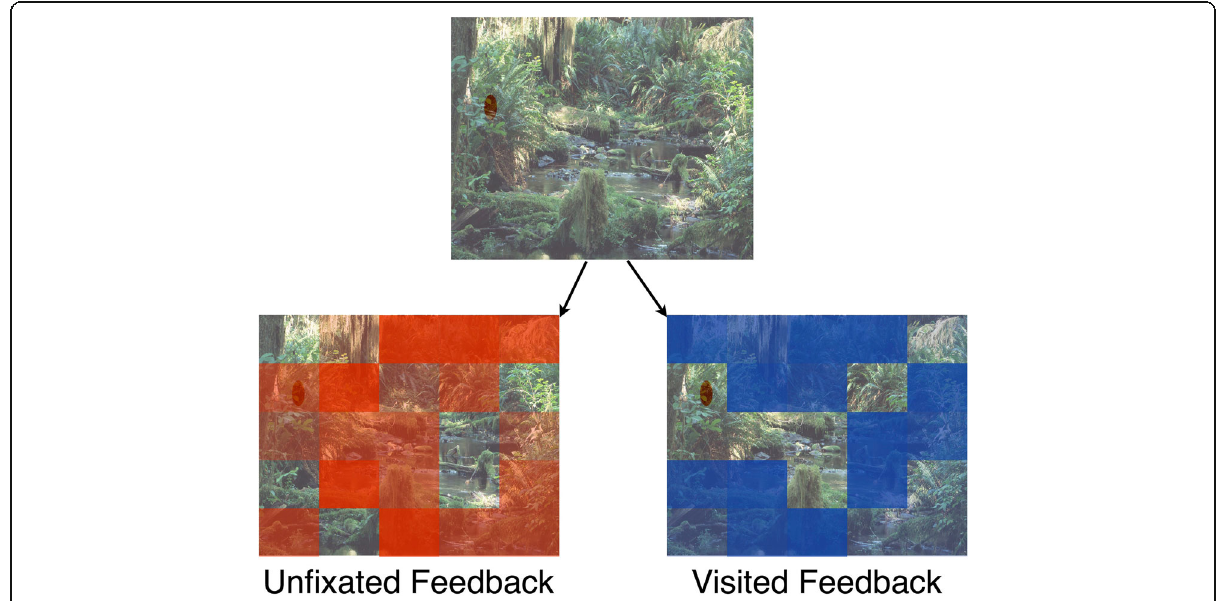
Fig. 1 Schematic representation of feedback systems employed in Experiments 1 – 3. The red target has been made larger and easier to detect for display